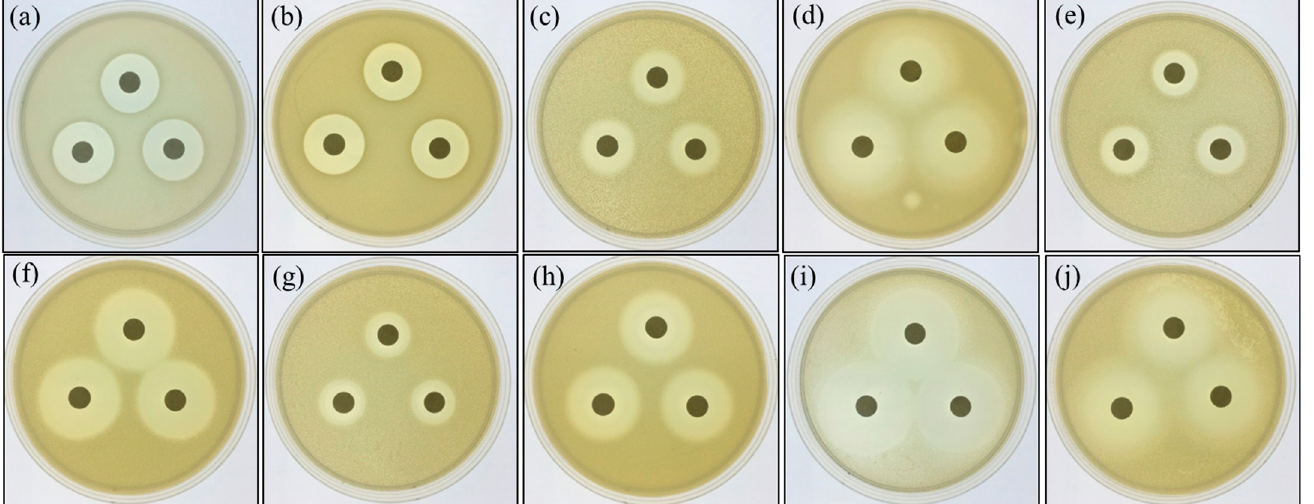
Figure 2. Antibiotic susceptibility of Paenibacillus ehimensis NPUST1 identified using the agar-well diffusion test after cultivation for 24 h. ( a ) Amoxicillin; ( b ) ampicillin; ( c ) chloramphenicol; ( d ) doxycycline; ( e ) erythromycin; ( f ) flumequine; ( g ) furazolidone; ( h ) kanamycin; ( i ) ormetoprim; ( j ) oxytetracycline. Experiments were conducted in triplicate on a TSB agar plate.